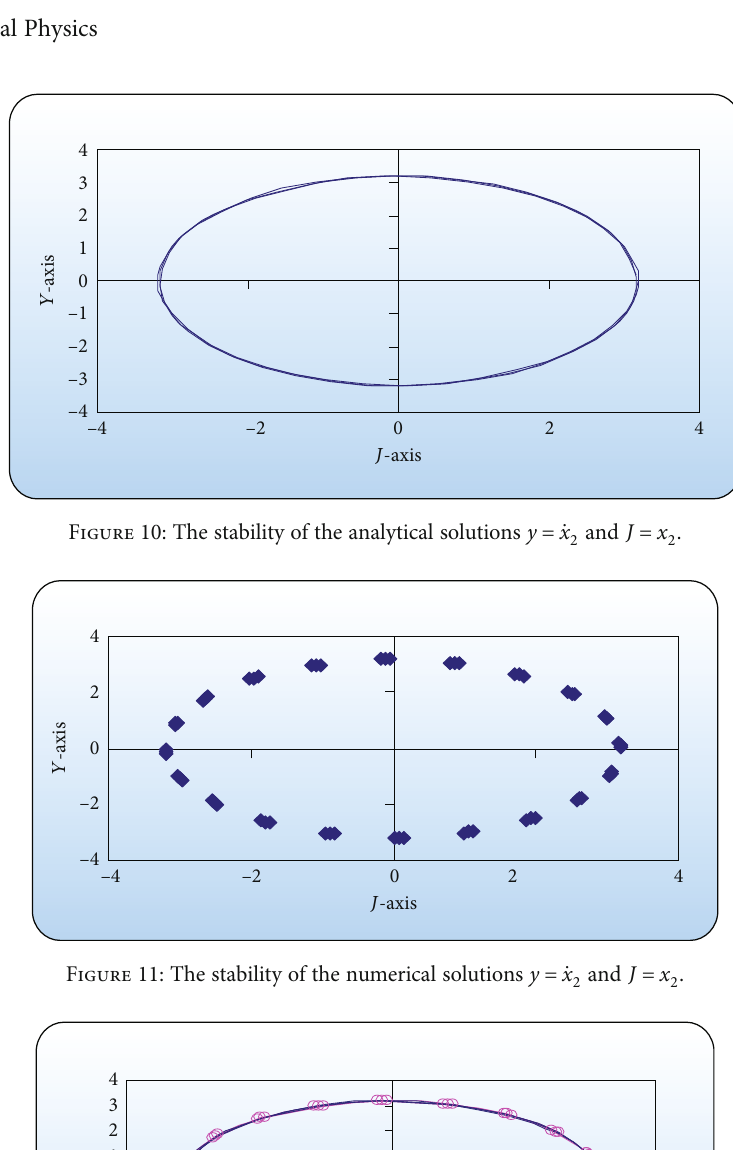
Figure 11: The stability of the numerical solutions y = _ x